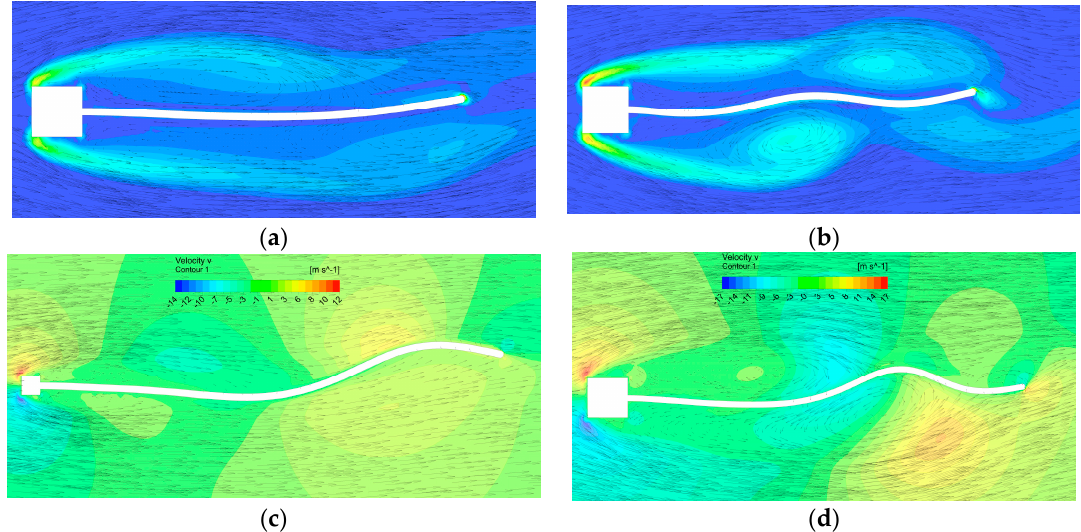
Figure 14. Velocity vectors and vorticity contours for high-strain-energy shapes for the plate L = 75 mm, D = 10 mm, t p = 100 µm, at ( a ) RE = 6218 ; ( b ) RE = 12162; transversal velocity v magnitude contours (m / s) and velocity vectors for high-strain-energy shapes, plate L = 100 mm, t p = 100 µm, at ( c ) u f = 20 m / s, RE = 5405, D = 4 mm ; ( d ) u f = 20 m/s , RE = 16,216 , D = 12 mm. Table 8. Simulations results for the plate L = 75 mm, t p = 100 µm.